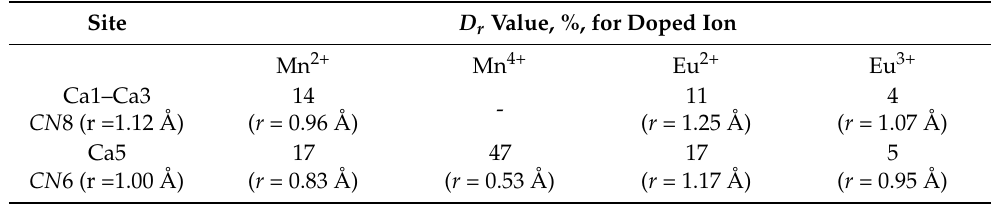
Table 4. Calculated D r values for Mn and Eu in different oxidation states in the β -TCP host. Site D r Value, %, for Doped Ion Mn 2+ Mn 4+ Eu 2+ Eu